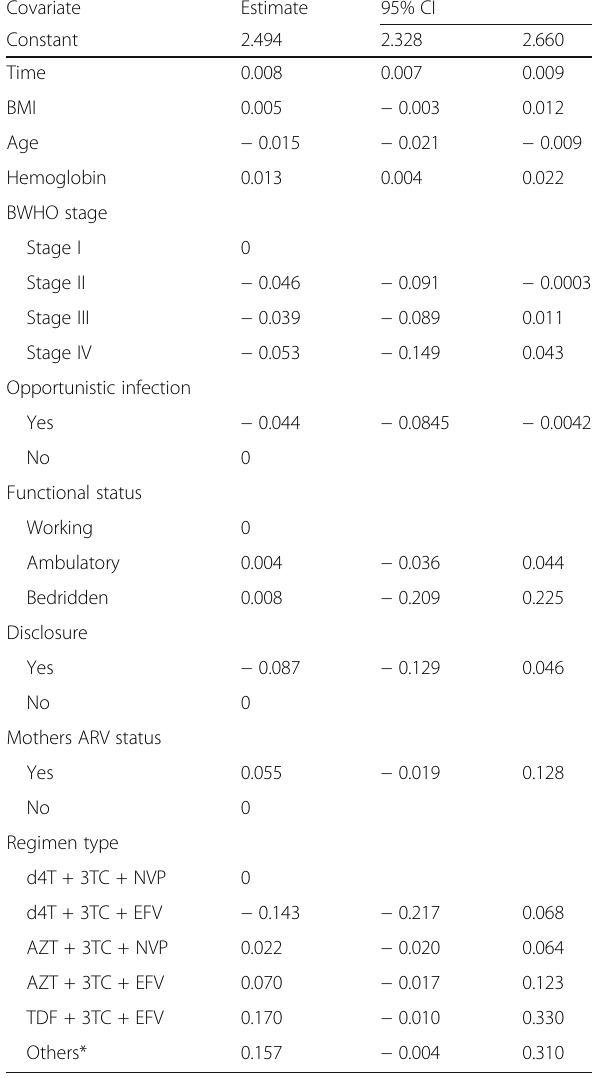
Table 3 Multivariable linear mixed model analyses of factors associated with CD4 changes overtime among HIV-infected children-initiated ART Amhara region public hospitals (2010